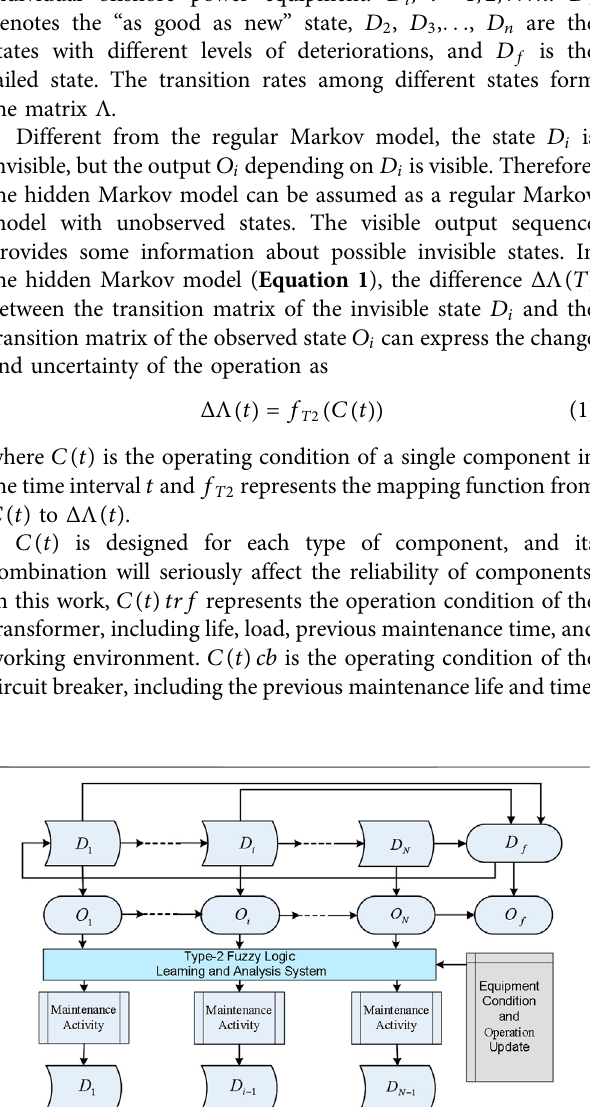
Figure 2 outlines the type 2 fuzzy hidden Markov model for